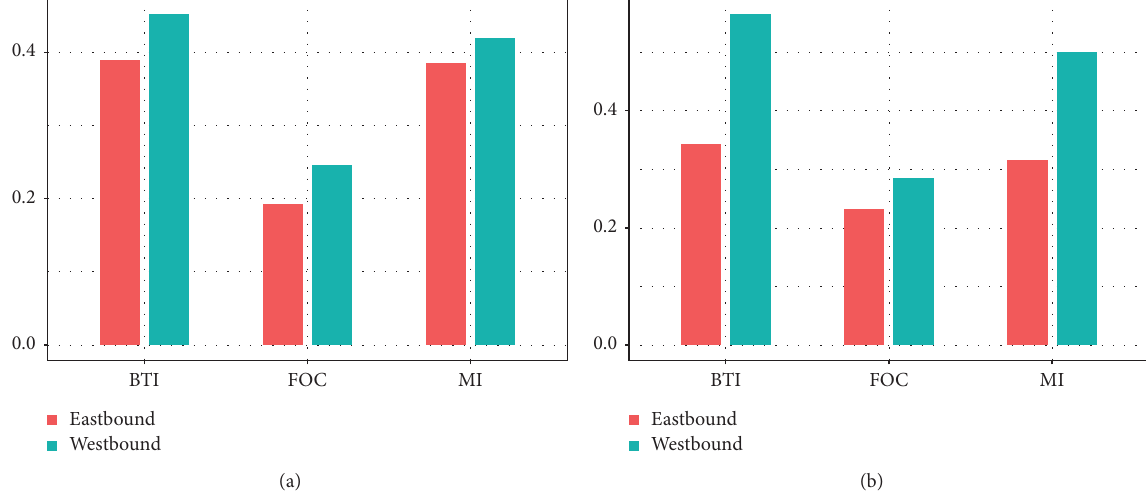
Figure 6: Buffer time index, misery index, and frequency of congestion of four routes. (a) Elevated expressway and (b) urban arterial